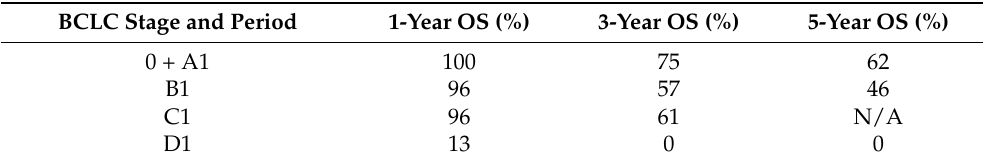
Table 3. Overall survival rates in 1, 3, and 5 years in the 1st period.